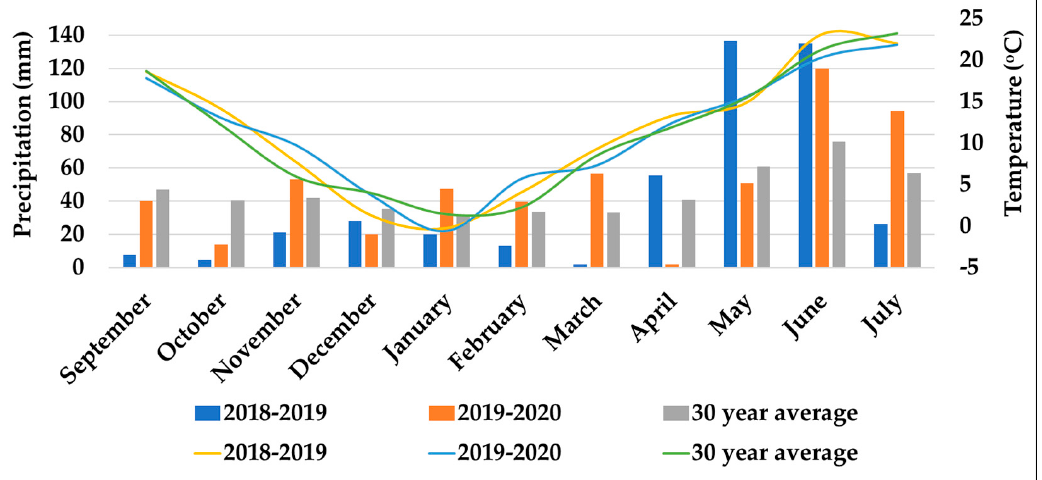
Figure 1. Average precipitation and temperature in the experimental years and in the last 30